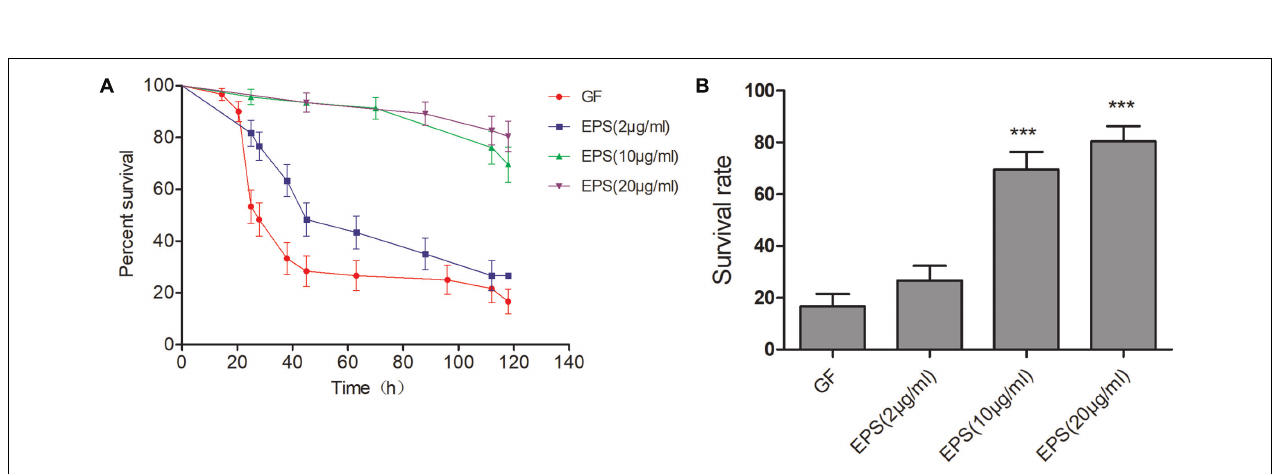
FIGURE 5 | Exopolysaccharides (EPS) extracted from L. casei BL23 protected against A. veronii infection in GF zebrafish larvae. The survival rate (A) and final survival rate (B) of GF zebrafish larvae treated with EPSP at a dose of 2, 10, and 20 µ g/mL, respectively after infected with A. veronii . Asterisks indicate significant difference compared with control ( ∗ P < 0.05, ∗∗ P < 0.01, ∗∗∗ P < 0.001).